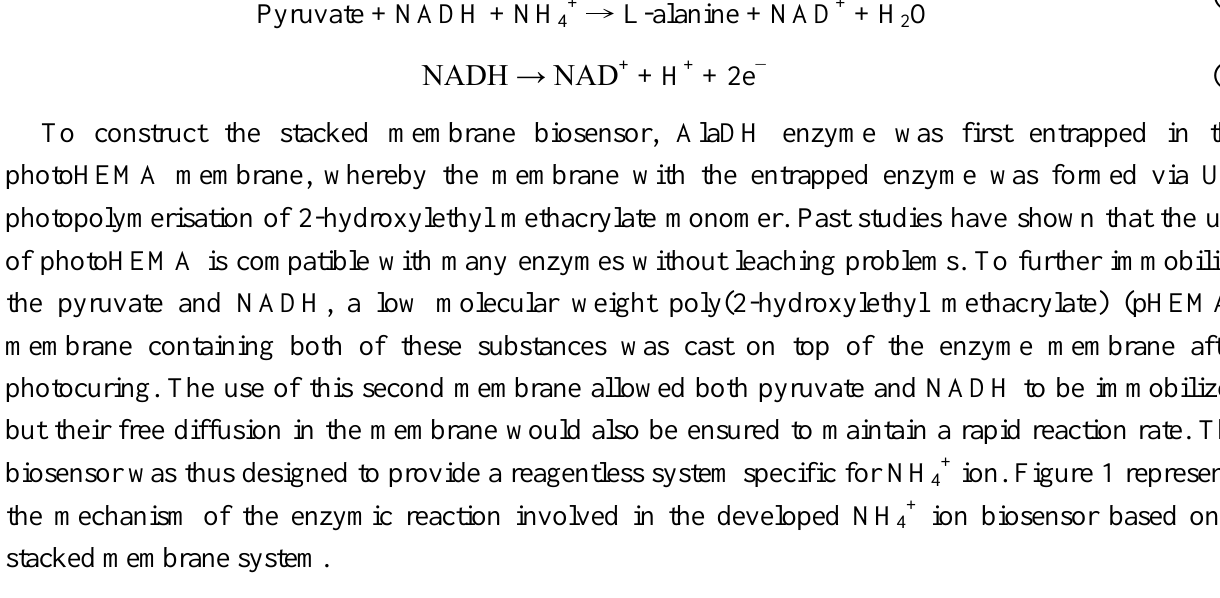
Figure 1. The mechanism of enzymatic reaction involved in the NH 4+ biosensor based on stacked